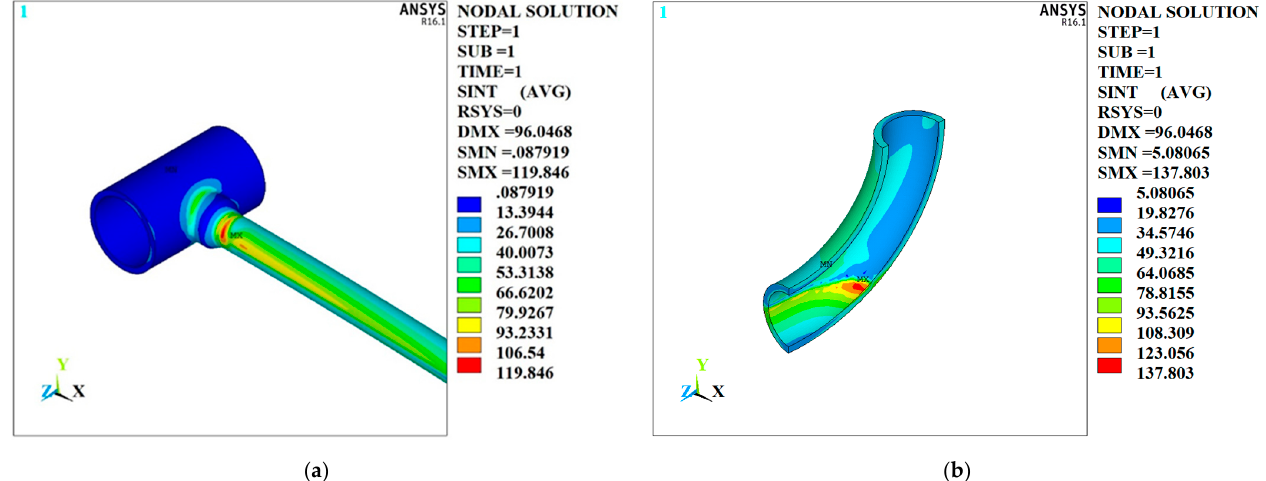
Figure 25. Stress intensity contour of two zones in stratification region. ( a ) Section A. ( b ) Section B.